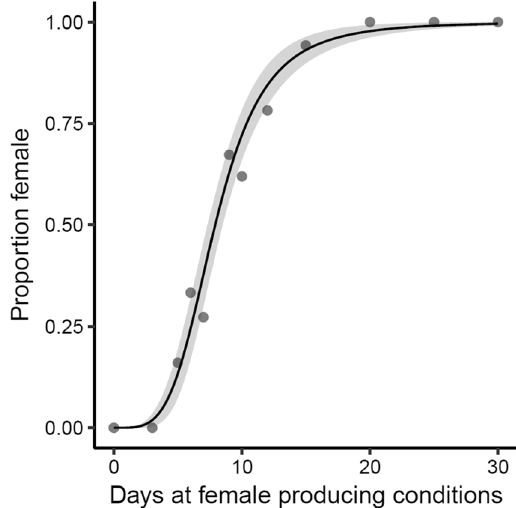
Figure 3. Populations did not differ in their responses to the incubation duration treatments. The curve depicts the population average sex ratio reaction norm. Points are proportions averaged across populations for each treatment and the ribbon is a 95% confidence